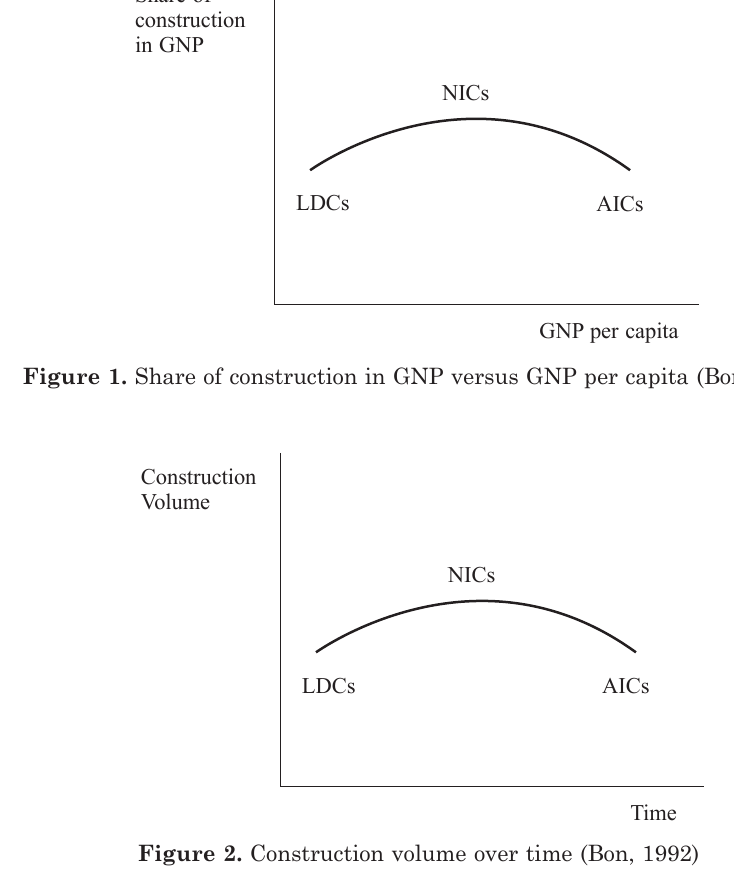
Share of construction